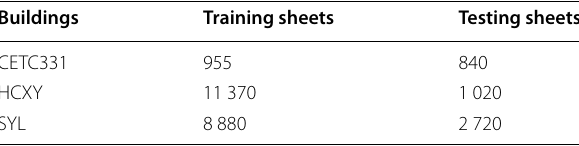
Table 5 Dimensions of RSS vector in simplified sheets